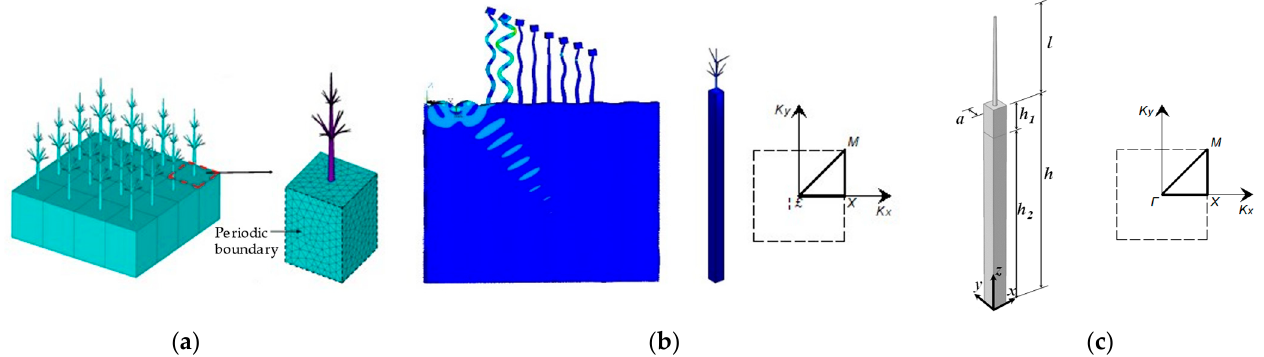
Figure 3. The 3D model of NMs interacting with Rayleigh waves: ( a ) The simulation model; ( b ) NMs converting surface waves to bulk waves the 3D model of; ( c ) Unit cell with viscous spring boundary.